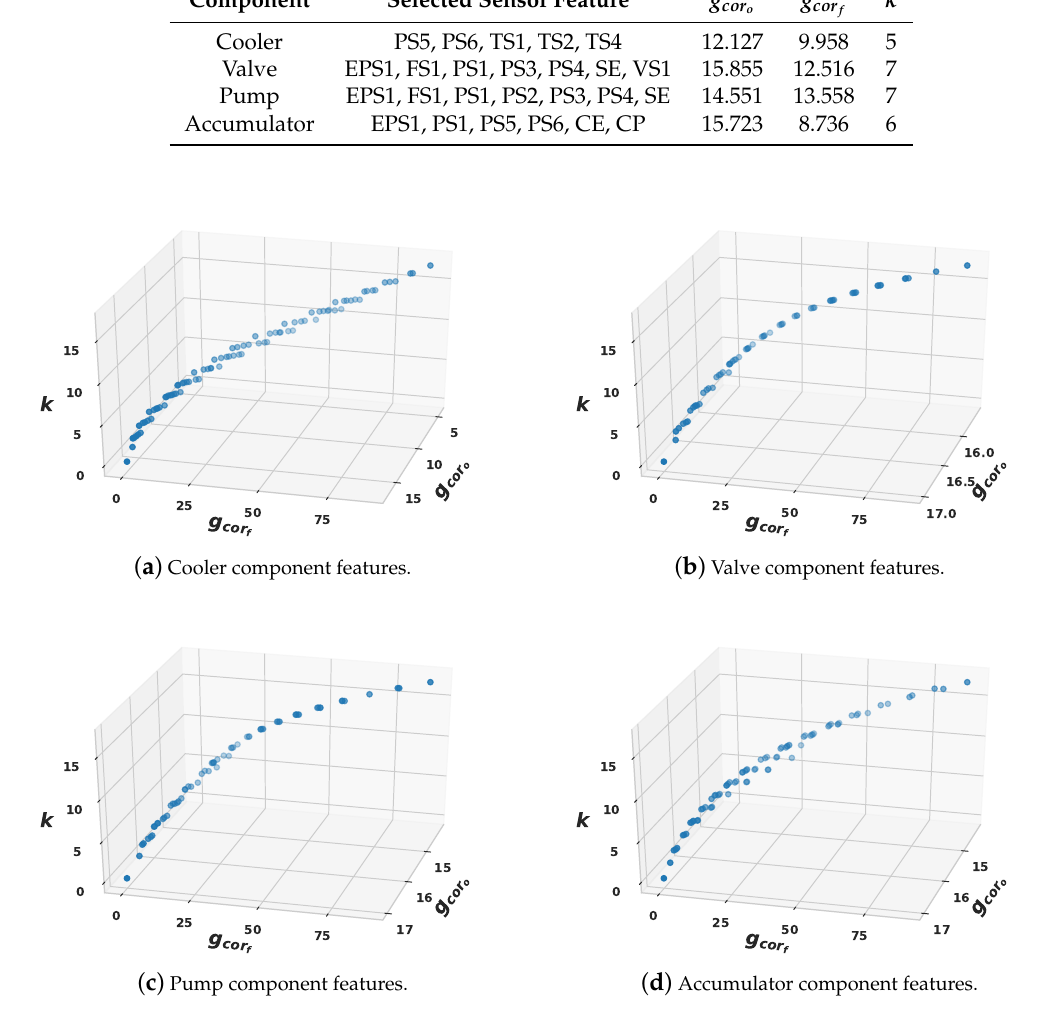
Figure 6. Pareto front for each fault type feature